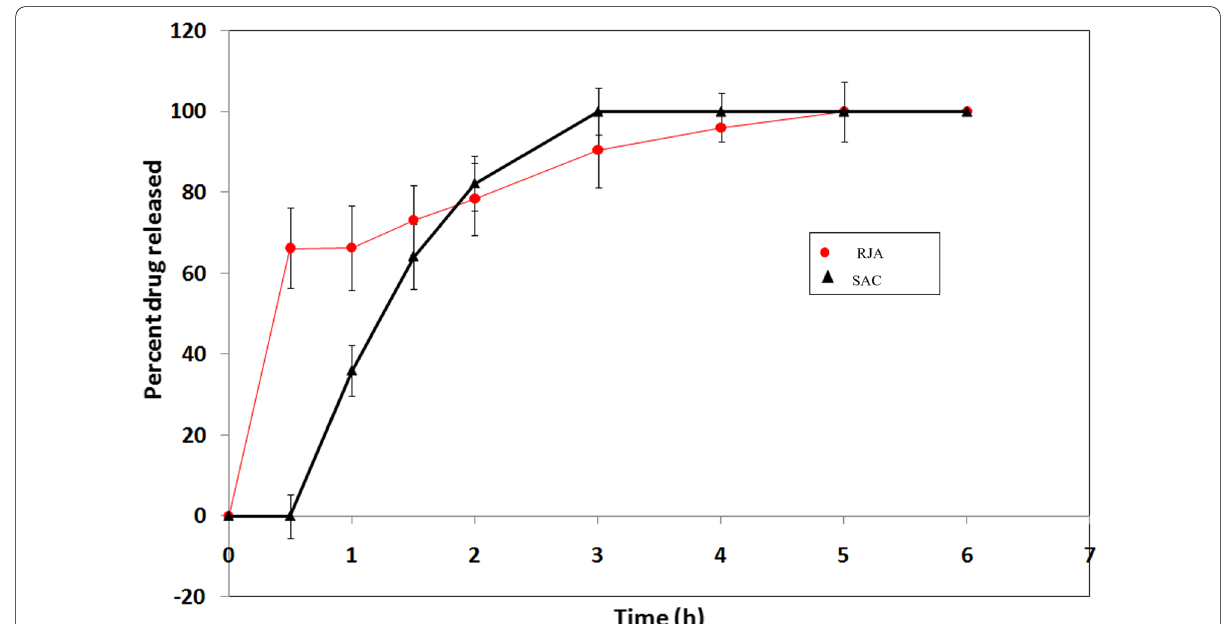
Fig. 1 Release profiles of RJA and SAC from Na alginate emulgel formula (MF 3 ) across dialysis cellulose membrane